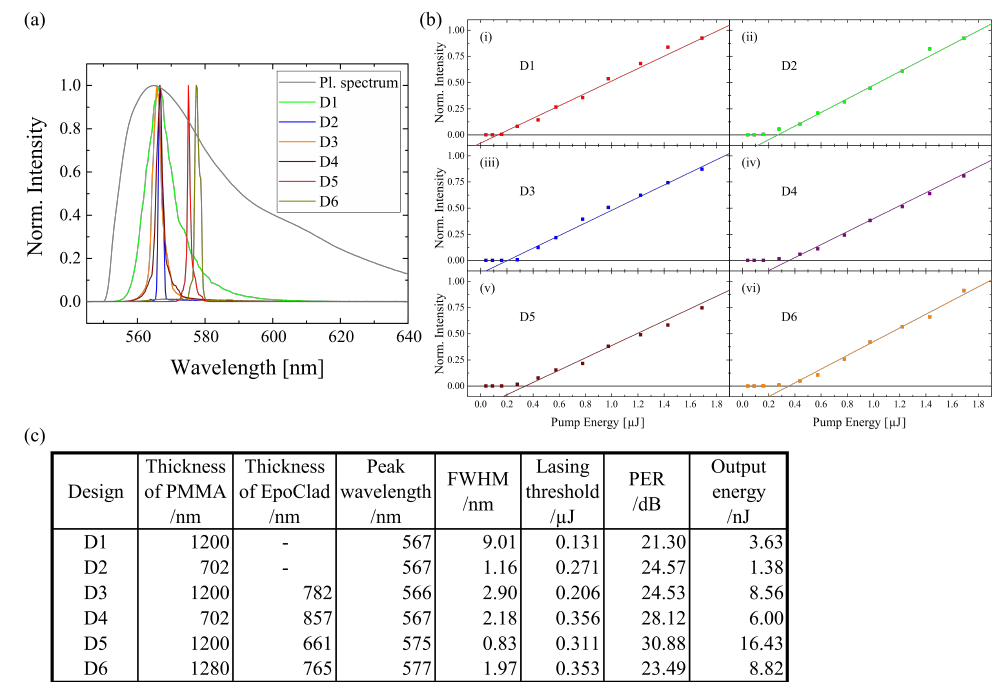
Figure 2. ( a ) The photoluminescence spectrum of Rh6G doped thin-film and the lasing spectra of design variation were shown. ( b ) The lasing threshold of different sample designs were evaluated. An overview of the lasing properties under the influence of the changes of sample design was presented in ( c